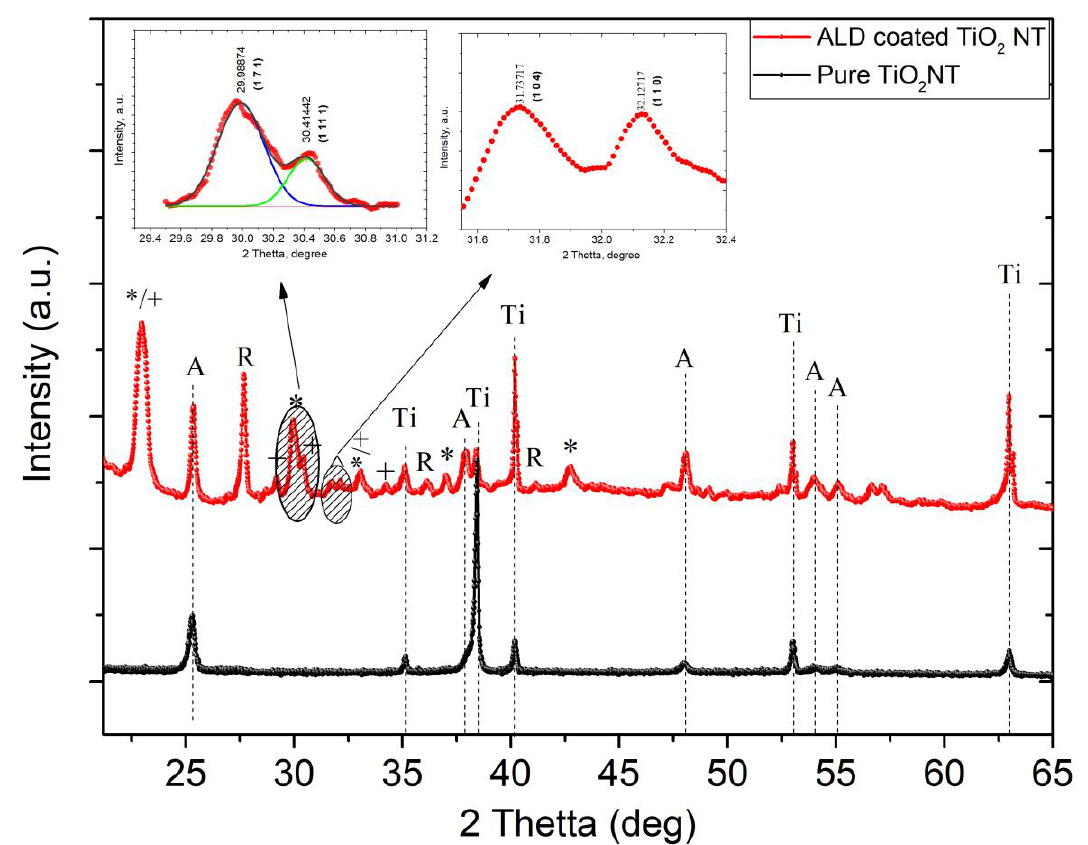
Figure 4. XRD patterns of pure and ALD-coated TiO 2 Nt. A—anatase; Ti—titanium; R—rutile; *—Bi 4 Ti 3 O 12 ; + —Bi 6 Fe 2 Ti 3 O 18 ; ˆ—BiFeO 3 . Insert ( left )—deconvoluted Bi 4 Ti 3 O 12 / Bi 6 Fe 2 Ti 3 O 18 peaks, ( right ) —BiFeO 3